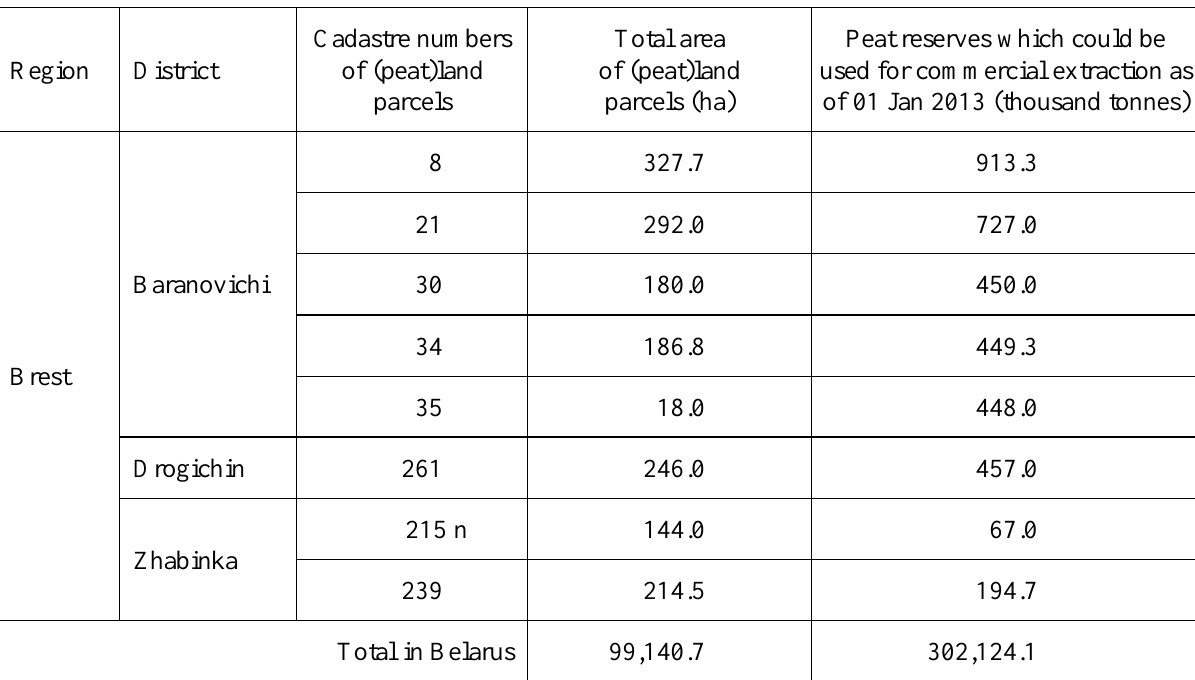
Table A2.5. Example data per district for (peat)land parcels that belong to the Exploitation Fund (reserved for peat